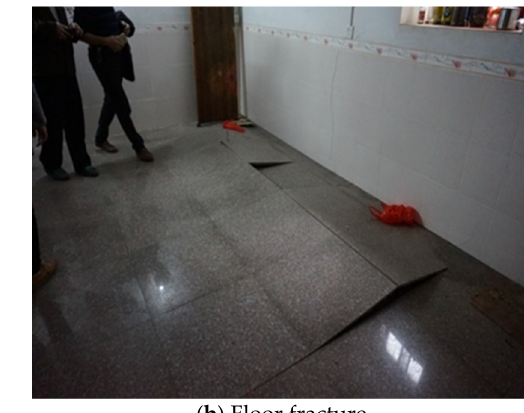
Figure 3. Slope moving forward and house cracking.